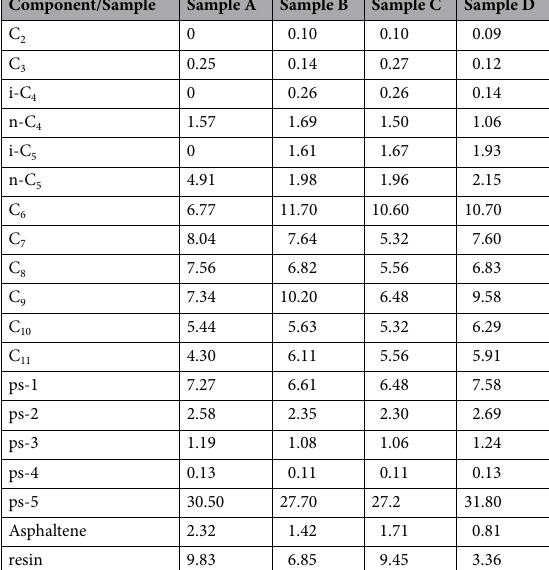
Table 2. The composition, resin, and asphaltene content of the oil samples.